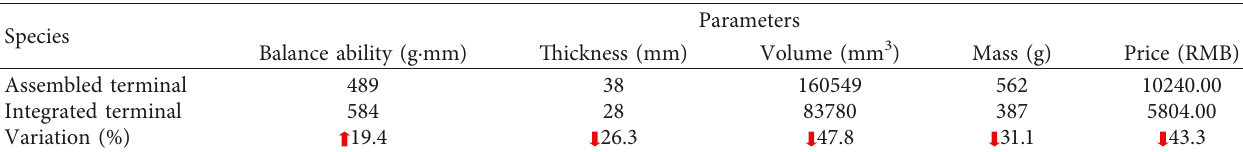
Figure 14: Comparison of 1/4 model. (a) Assembled terminal. (b) Integrated terminal. Table 1: Comparison of two balanced terminal